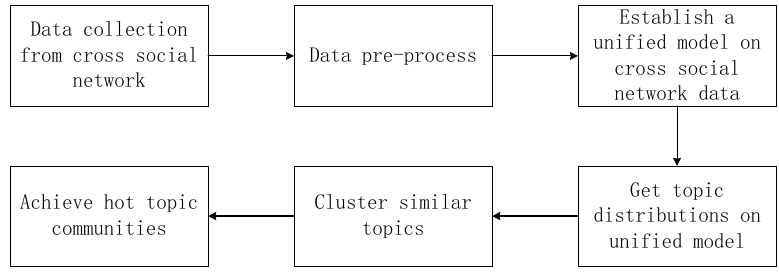
Figure 1. General process of our model.